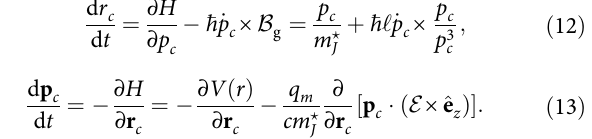
¼ q σ jBj = 2 m ? is e m J